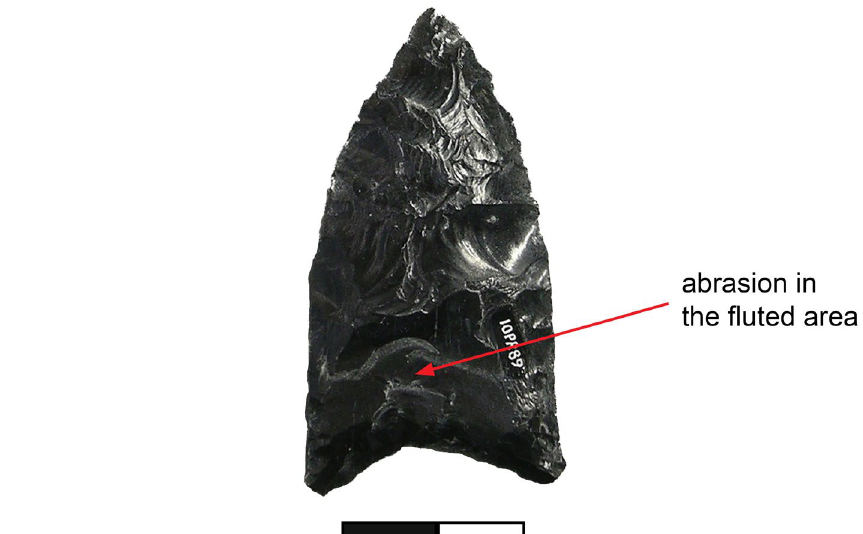
Figure 6. The Seagull Bay Clovis fluted point that has pronounced scratches in the fluted area on one of its faces (image after Slade 2016). The scale bar is 2cm wide (in 1 cm